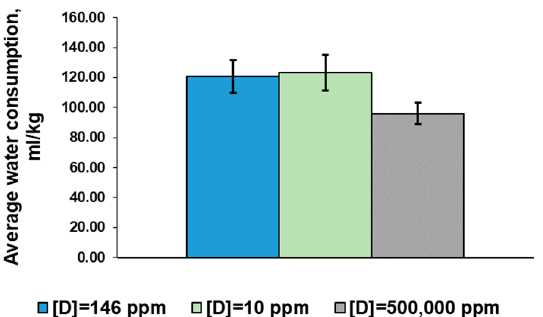
Figure 2. Average daily consumption of water with modified deuterium content by the rats per kg body weight. Data are shown as mean ± S.E.M.